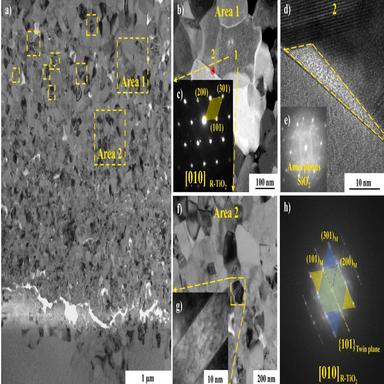
Microstructure and phase composition of the oxide scale: (a) TEM-BF image containing oxide scale, interface and substrate, (b) TEM-BF image of "Area 1′′ marked in (a), (c) SAD patterns of "point 1′′ marked in (b), (d,e) HRTEM image of "point 2′′ marked in (b) and its FFT diffraction patterns, (f) TEM-BF image of "Area 2′′ marked in (a), (g,h) HRTEM image of the corresponding area in (f) and its FFT diffraction patterns.